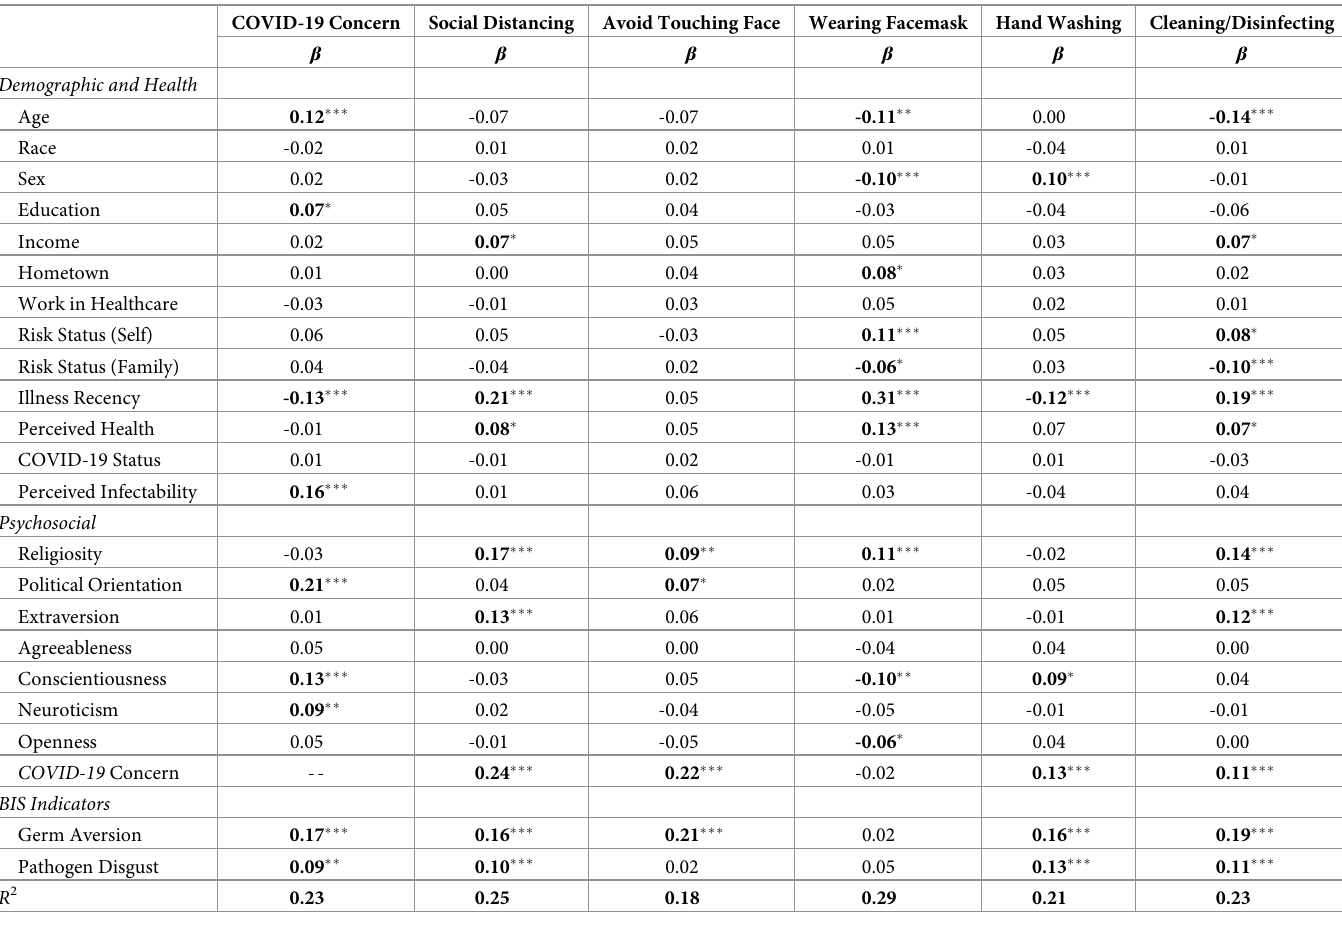
Table 3. Regression model results for COVID-19 concern and preventative health